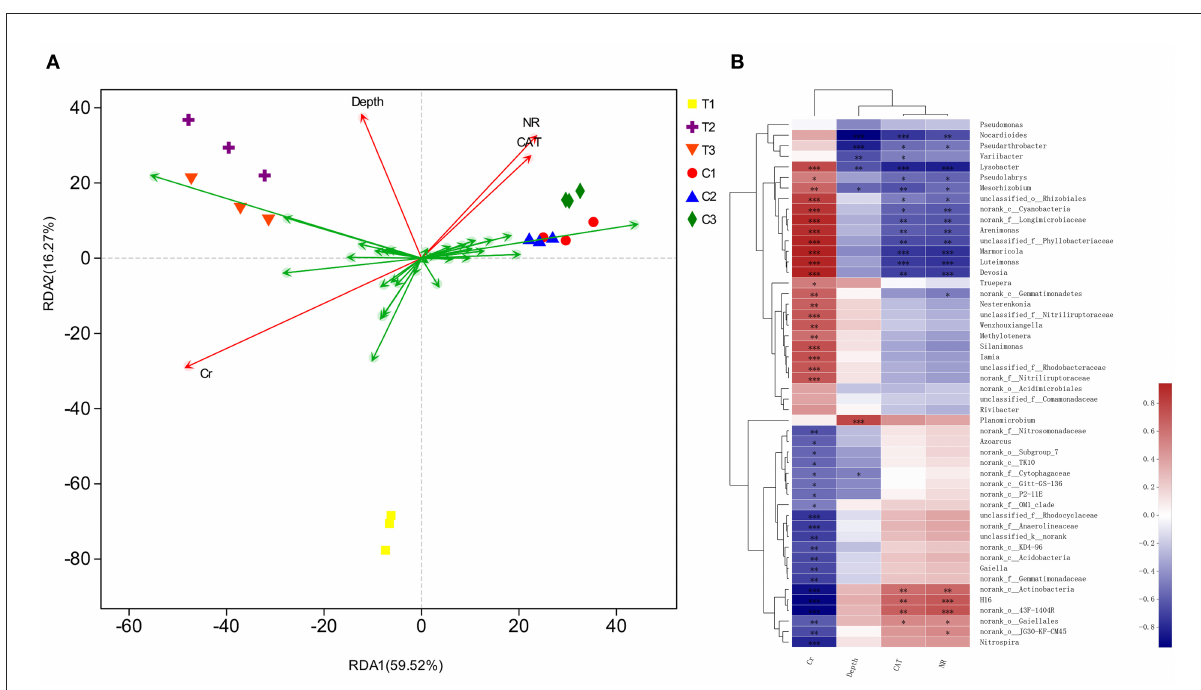
FIGURE12 Based on different environmental factors, RDA result of bacterial communities (A) and heatmap of correlations (B) in soil samples. Values in the same row with “*, **, and ***” were significantly different ( p < 0.05, p ≤ 0.01 or p ≤ 0.01). All data in the experiment are from three independent